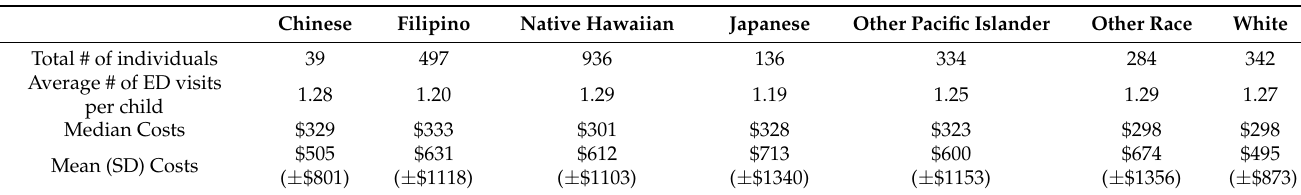
Table 3. Descriptive data for potentially preventable ED visits by individuals with asthma by race or ethnicity in Hawai‘i from Hawai‘i Health Information Corporation Data, 2015–2016 a,b .